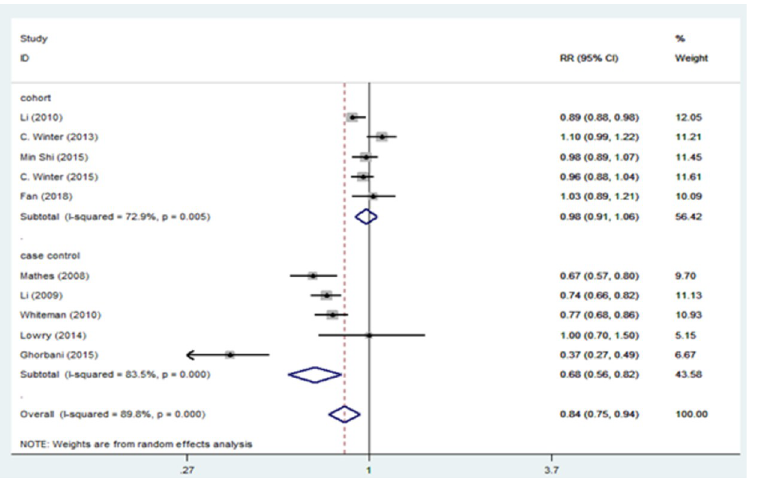
Fig 2. Forest plot of the association between migraine and breast cancer by study design.